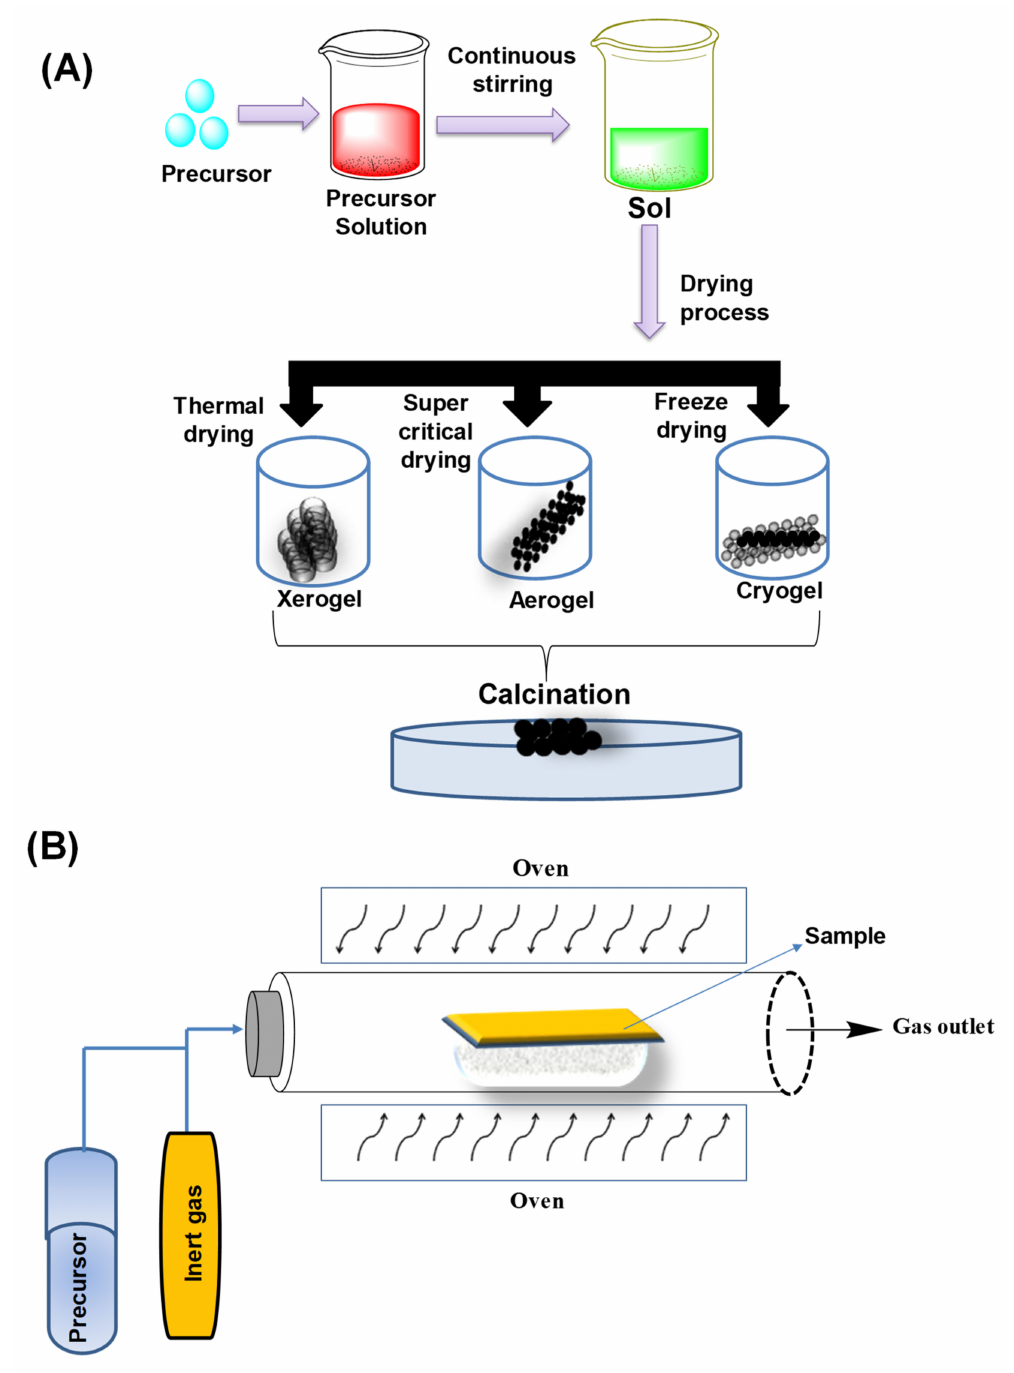
Figure 4. ( A ) Sol–gel method for nanoparticle synthesis. ( B ) Chemical vapor deposition (CVD)